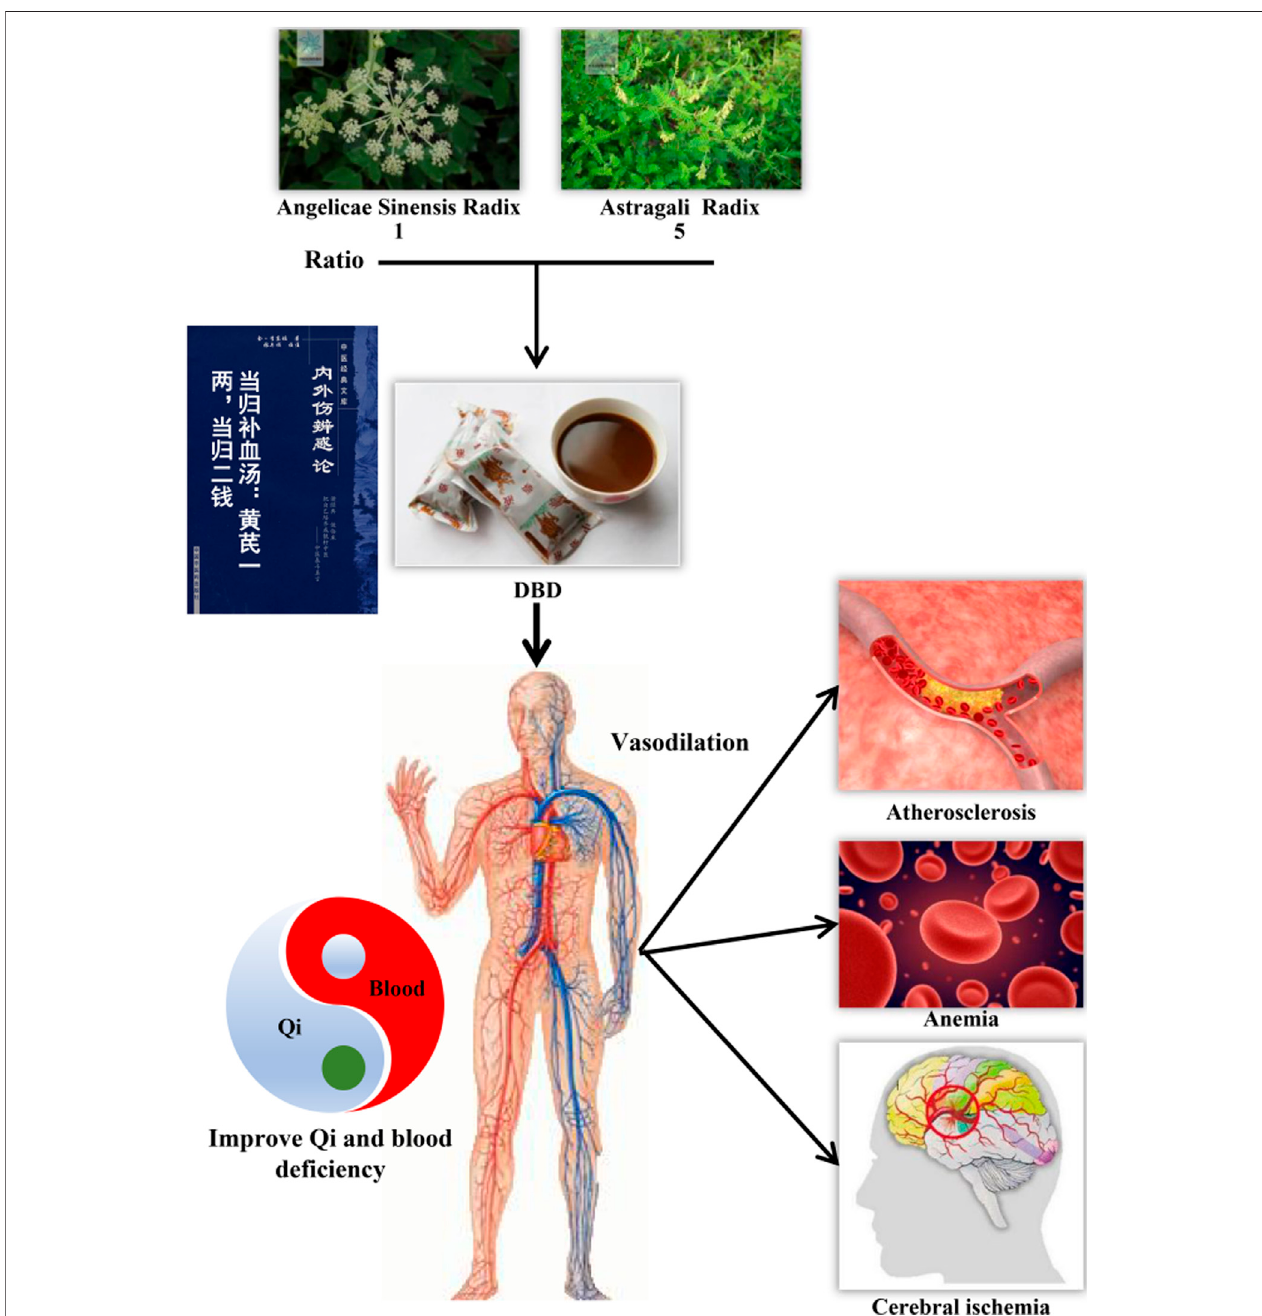
FIGURE 1 | Origin and function of DBD in traditional Chinese medicine. DBD was originally recorded in Differentiation on Endogenous (Neiwaishang Bianhuo Lun, I 内 外 伤 辨 惑 论 J ), which was composed of AR and ASR in a ratio of 1:5. DBD ameliorated the de fi ciency of Qi and blood by tonifying Qi and generating blood, thus treating atherosclerosis, anemia, and diseases related to cerebrovascular injuries. AR, Astragali Radix. ASR, Angelicae Sinensis Radix. DBD, Danggui Buxue decoction.